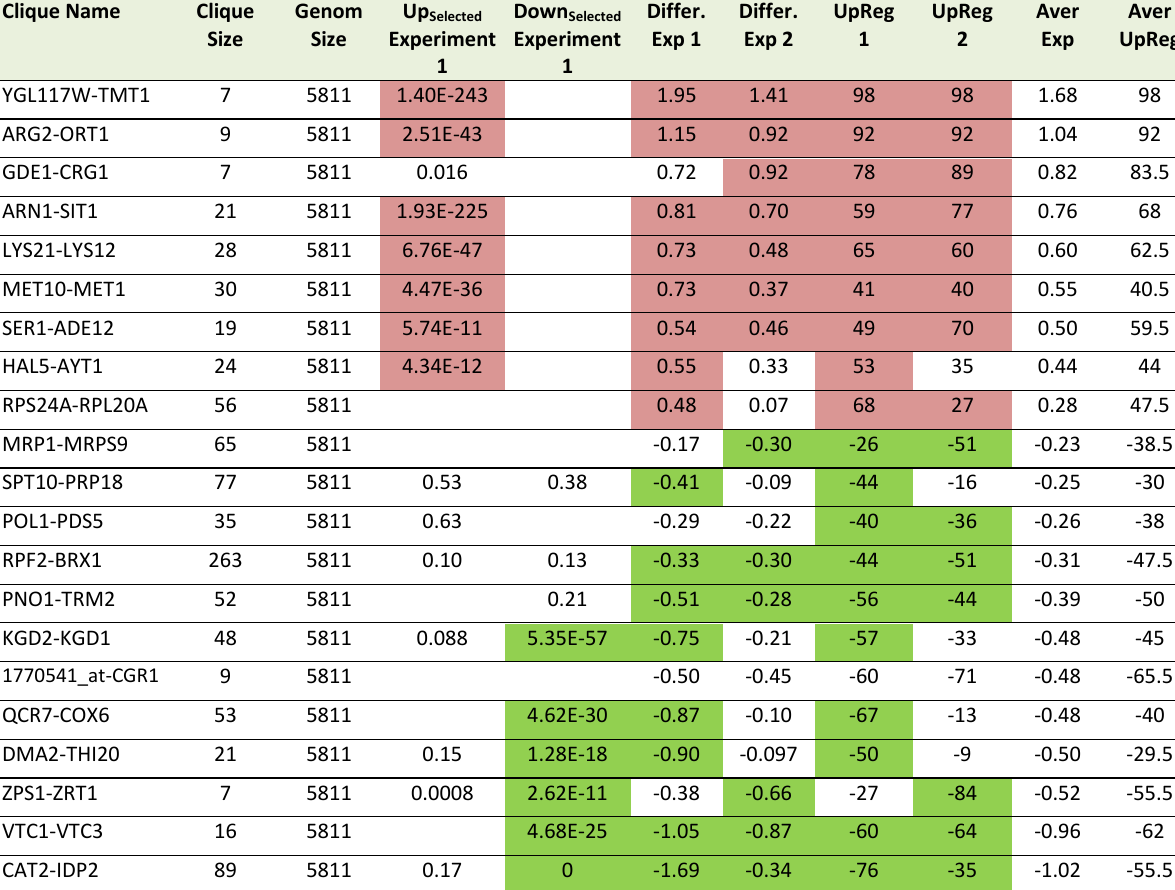
TABLE 6. Most prominent hits from differential expression between Q56 and Q0 within the 72 expression cliques. Clique